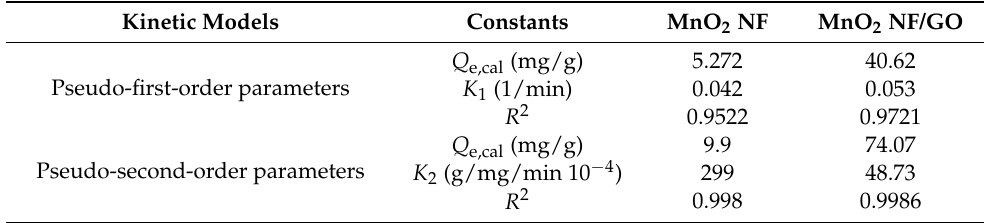
Table 2. Parameters of kinetics models for the BbFA adsorption by as-synthesized composites. Kinetic